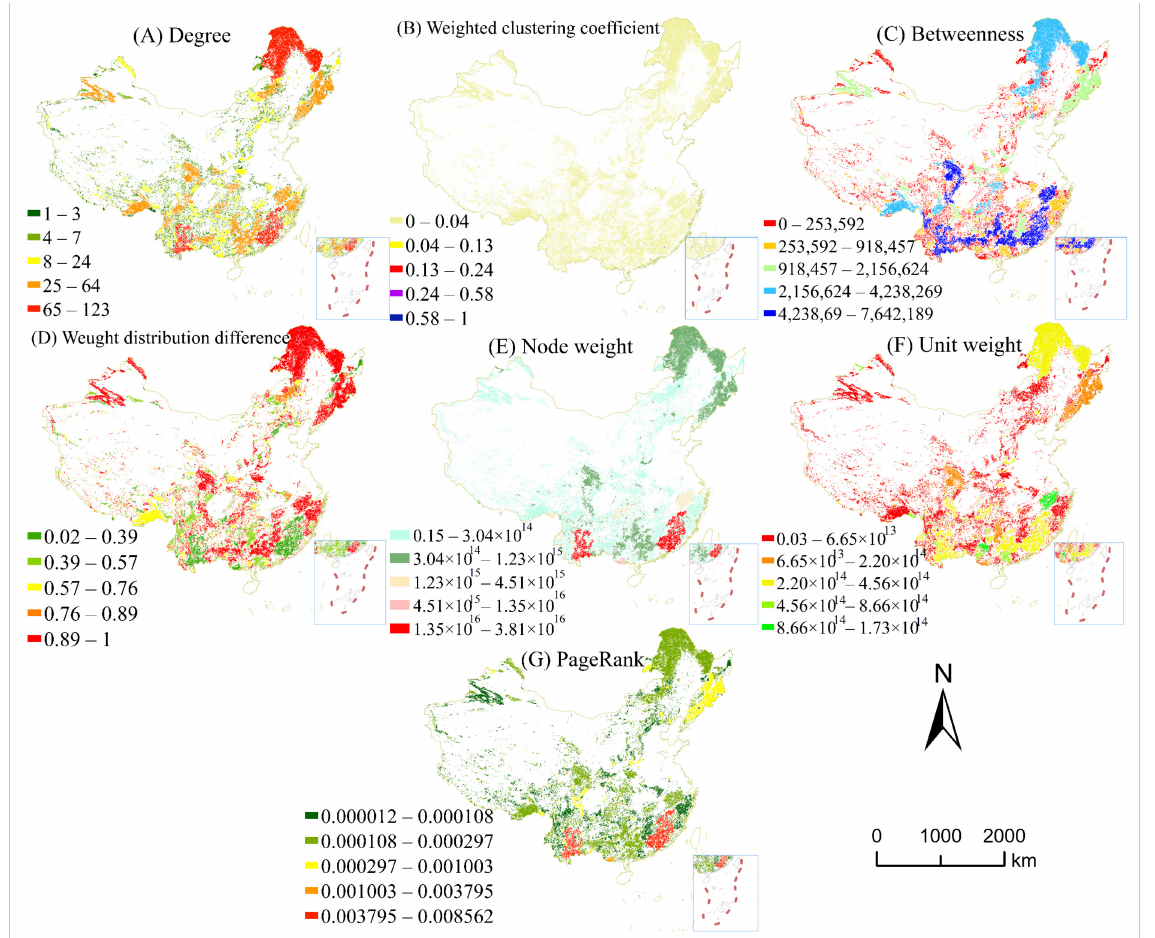
Figure 9. Ecospatial network topology index degree ( A ), weight clustering coefficient ( B ), between- ness ( C ), weight distribution difference ( D ), node weight ( E ), unit weight ( F ), PageRank ( G